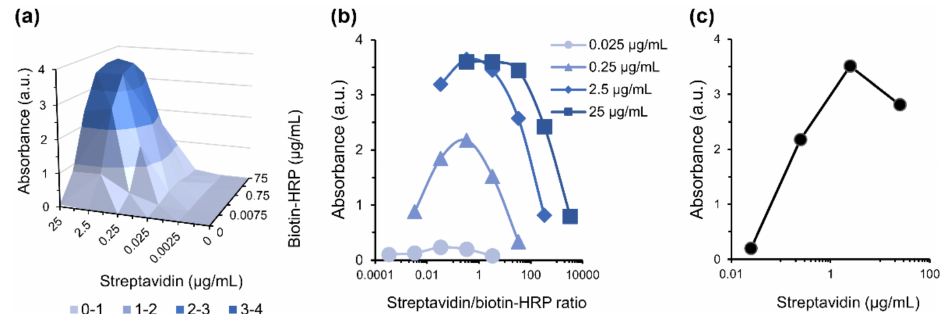
Figure 4. Streptavidin/biotin–HRP binding assay. ( a ) Absorbance values measured as a function of different streptavidin and biotin–HRP concentrations ( µ g/mL); ( b ) absorbance values measured as a function of streptavidin/biotin ratio, for streptavidin concentrations between 0.025 and 25 µ g/mL; ( c ) absorbance values measured as a function of streptavidin concentration ( µ g/mL), for all combina- tions of streptavidin/biotin–HRP at the ratio of